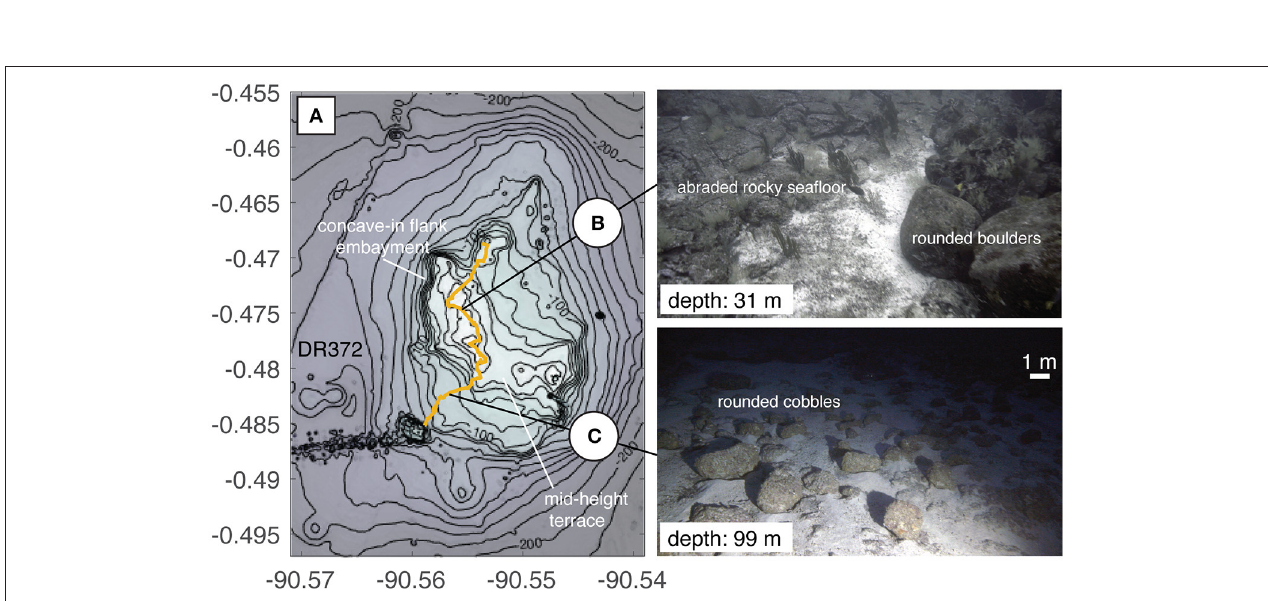
FIGURE 6 | Map of DR372 seamount. (A) Bathymetric contour interval is 10m. Gold line shows dive track for seamount DR372. This seamount is highly irregular in shape, with a N-S trending elongation at it’s base and NW-SE elongation near it’s summit. The seamount has steep upper flanks and is adorned by multiple irregular summit features. There are multiple terraces on this seamount, which are flanked by steep sides with flank embayments. ENE-WSW striking linear feature SW of the seamount is a data artifact. (B) Rounded boulder on smoothed bedrock material constituting the seamount’s terrB The left portion of the image shows bulbous/rounded basaltic lava flow bedrock and the right side shows rounded basaltic boulders of a similar size and roundness. (C) Field of rounded cobble-boulder sized clasts on flat lying bedrock, which is mostly obscured by fine sediment. Depths in photos indicate the depth of the seafloor at the point of image capture.